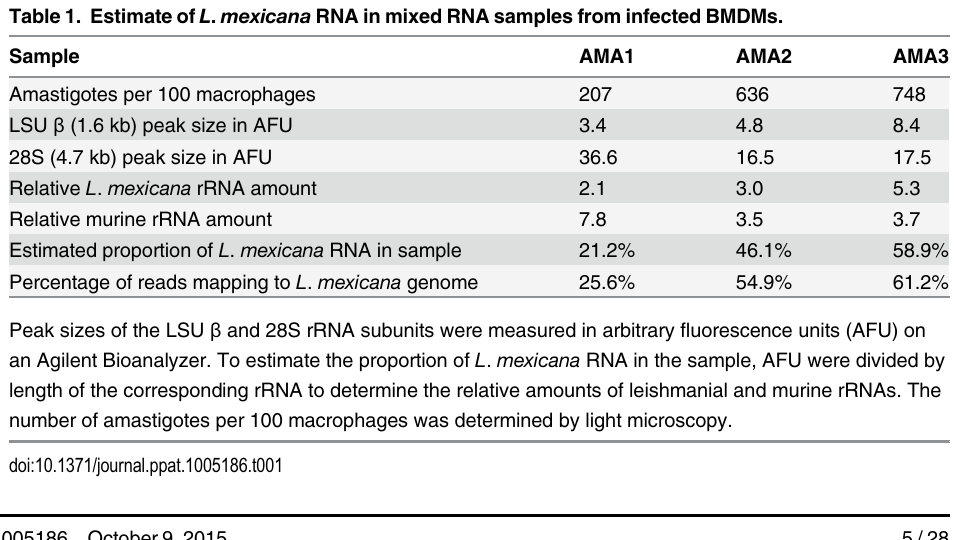
sequence (SL) were mapped to the L . mexicana genome (see materials and methods and [46]). In total, 6,942,183 SL-containing reads were mapped to 21,249 positions in the genome (S1 Table). Ninety-six percent of SLAS mapped to an AG dinucleotide consistent with the known conserva- tion of this dinucleotide at the vast majority of mapped kinetoplastid trans-splice sites [30,42]. To map the sites at which poly-A tails were added to transcript 3 ’ ends (PAS) a second T15VN- primed library was generated from two of the RNA samples for each cell type (see materials and methods). 3,939,551 reads containing at least 5 consecutive A nucleotides at the 3 ’ end were mapped to 96,522 positions in the genome (materials and methods, [46]) (S2 Table).